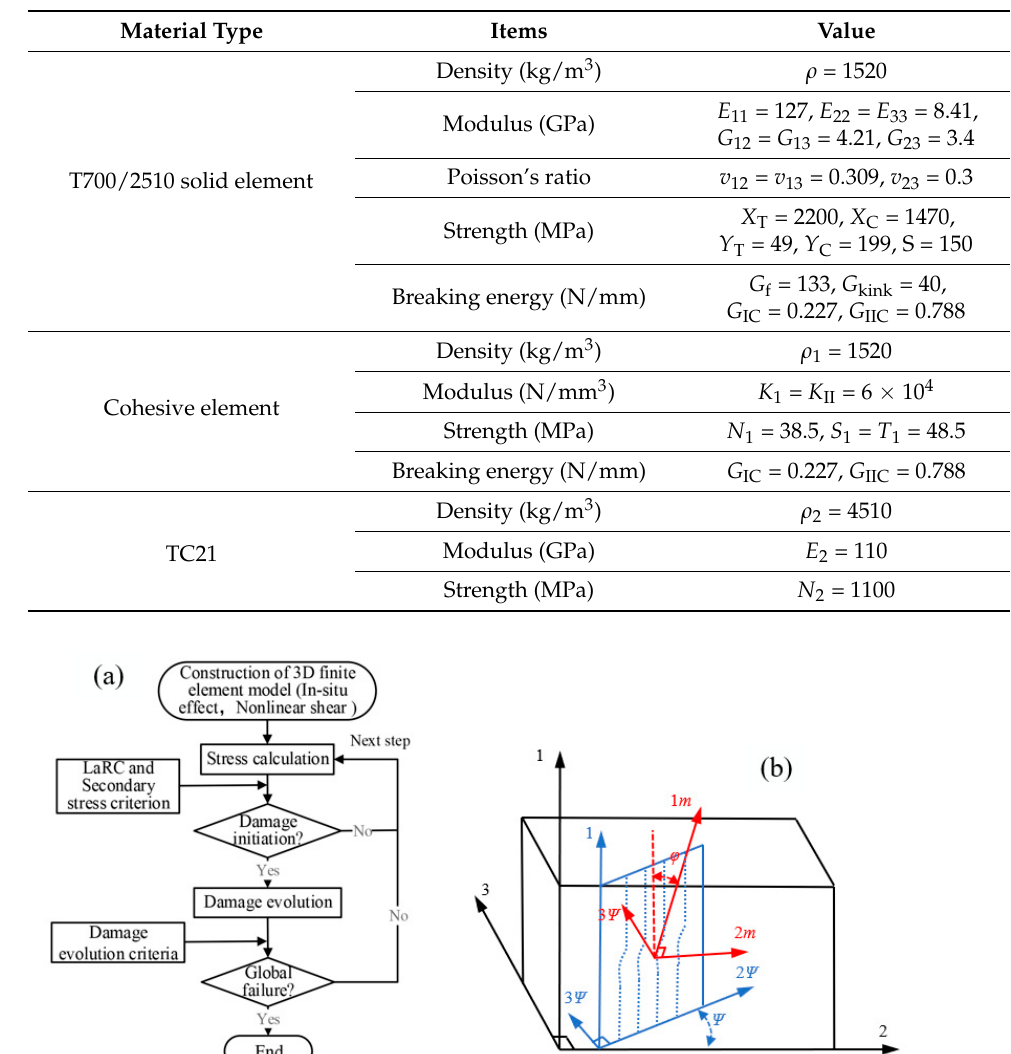
Table 1. Properties of CFRP single-lap material [25].